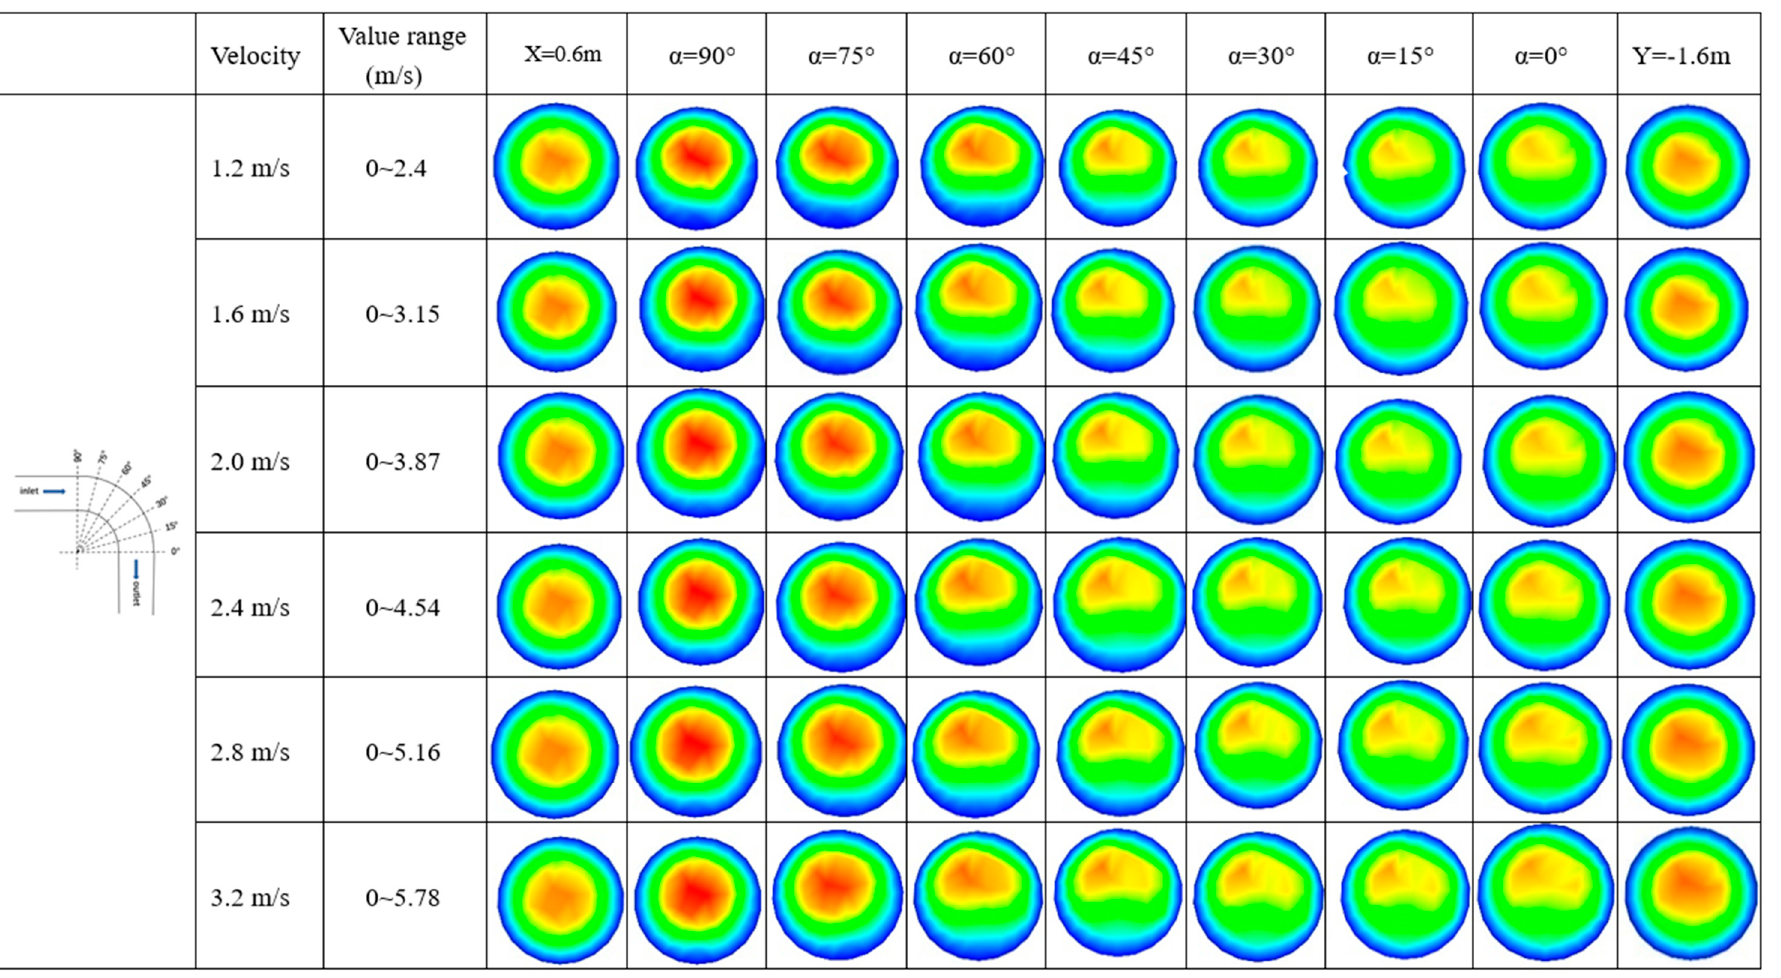
Figure 6. Cross-sectional contours of velocity distribution of CPB at horizontal–vertical bend pipe.